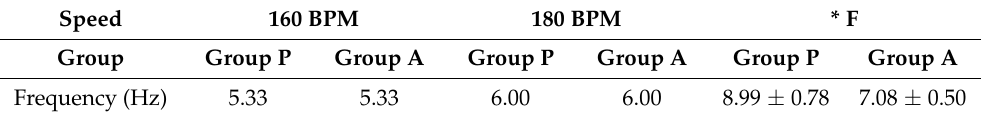
Table 2. Descriptive speed levels for professional and amateur groups (n = 12).